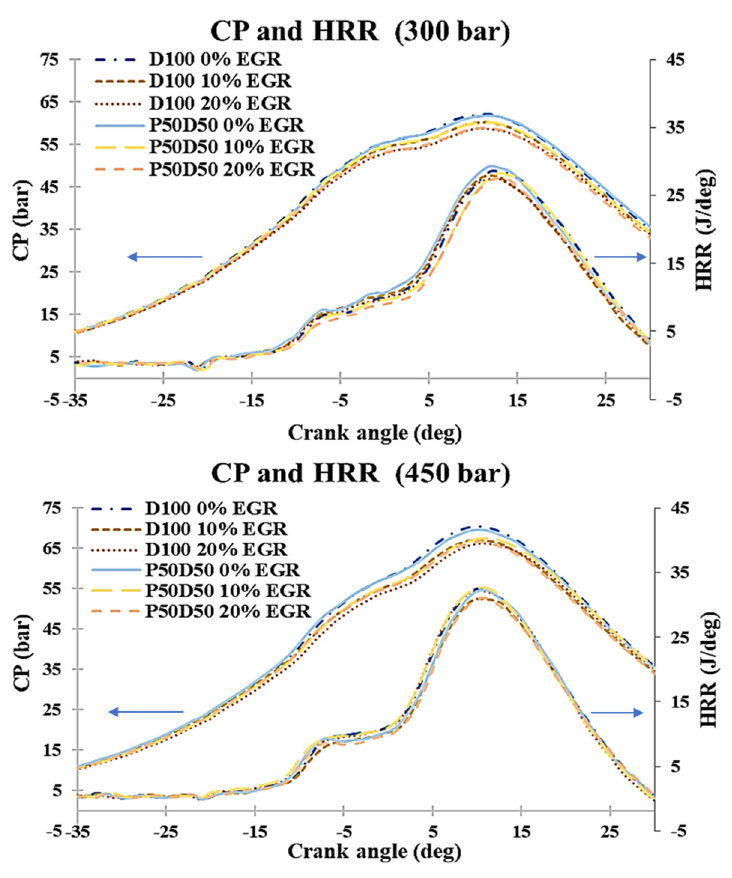
Figure 9. CP and HRR under different EGR rates at 300 and 450 bar.